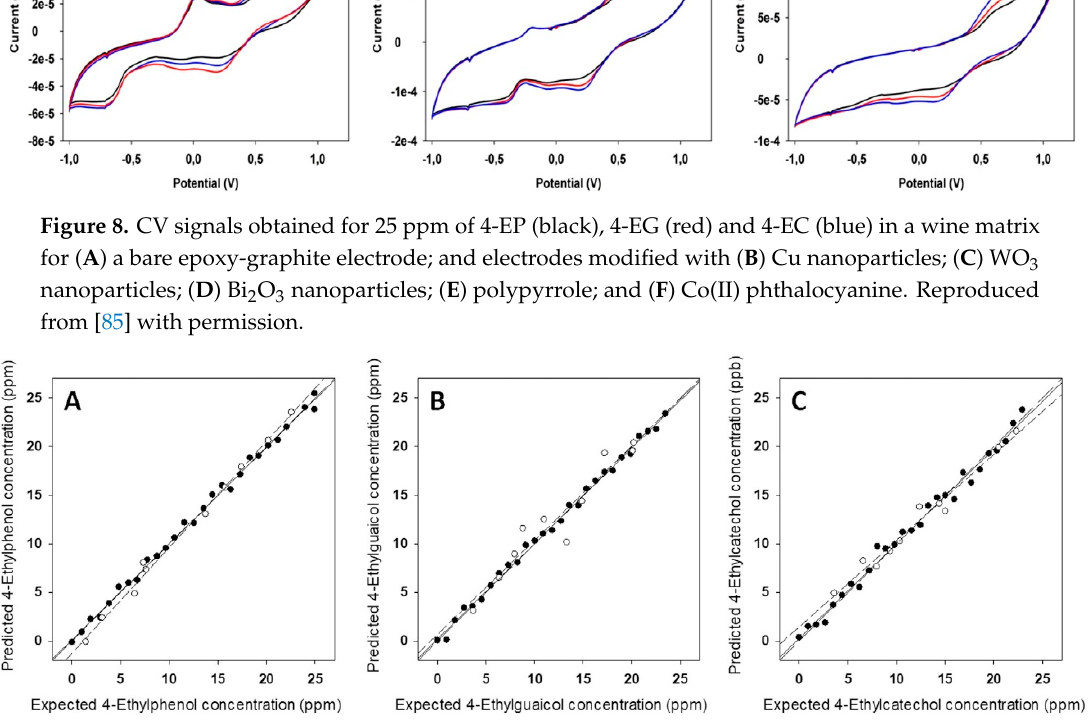
Figure 9. Modeling ability of the developed ANN: expected vs. predicted concentrations for ( A ) 4-EP; ( B ) 4-EG; and ( C ) 4-EC, both for training (•, solid line) and testing subsets ( ○ , dashed line). Dotted line corresponds to theoretical diagonal line. Reproduced from [85] with permission.